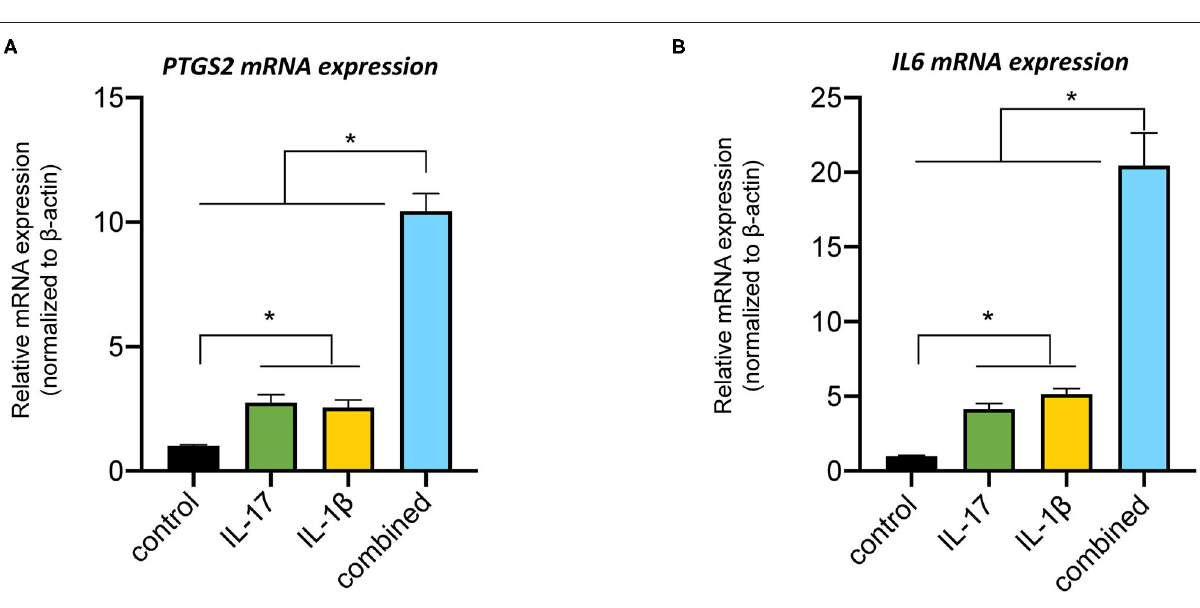
B (NF- κ B) and mitogen-activated protein kinase (MAPK) pathways were activated at 24 h and 48 h ( Figure 3C